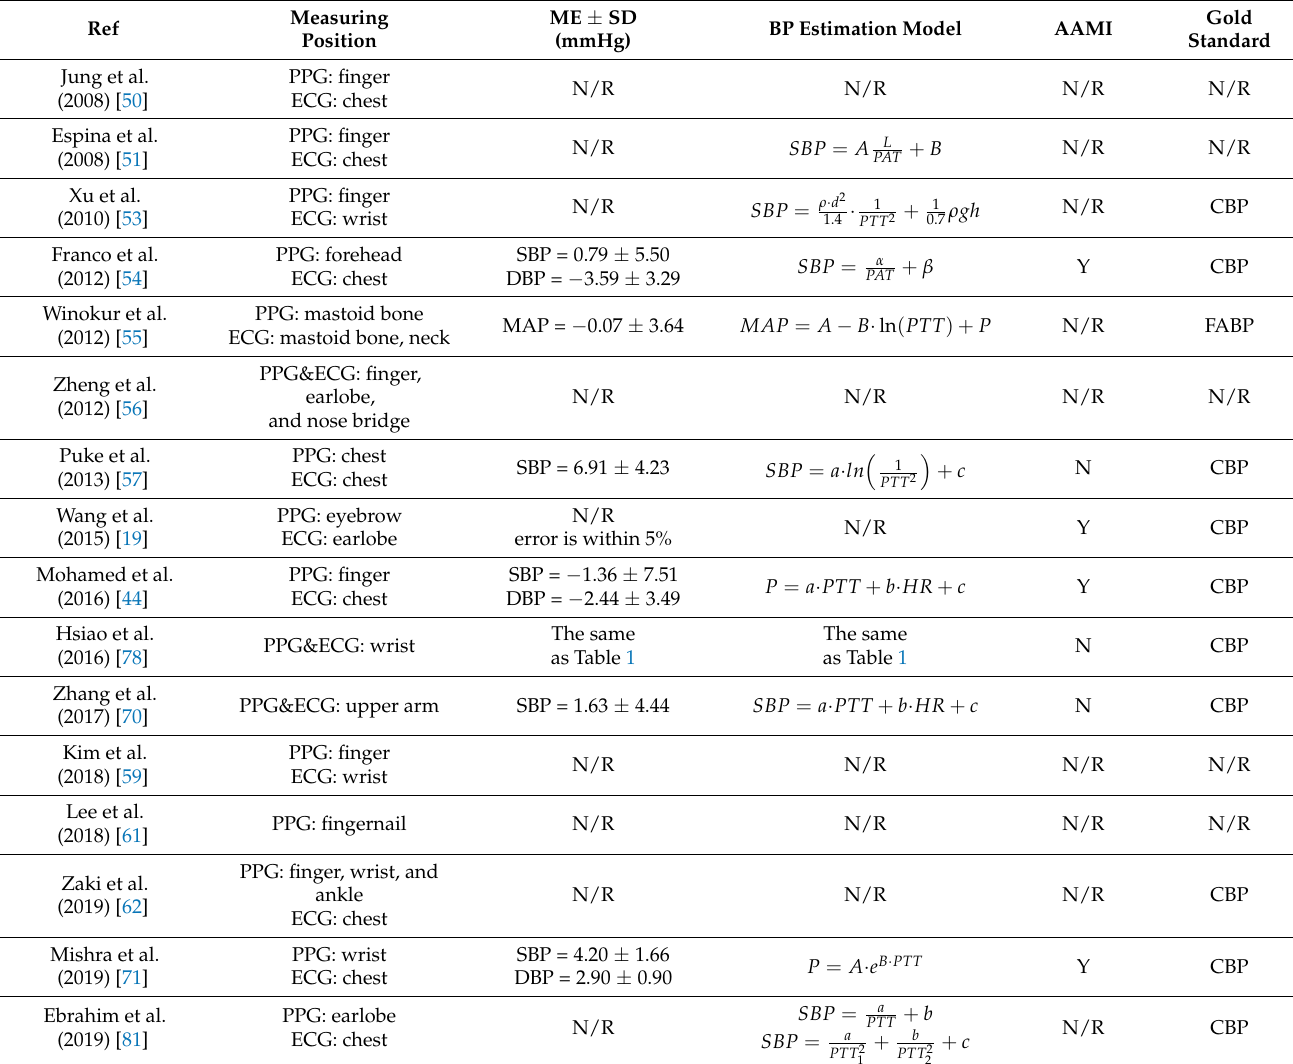
Table 2. Some details of the reference. N/R: not reported, Y: satisfied, N: unsatisfied, CBP: cuff blood pressure, FABP: finger arterial blood